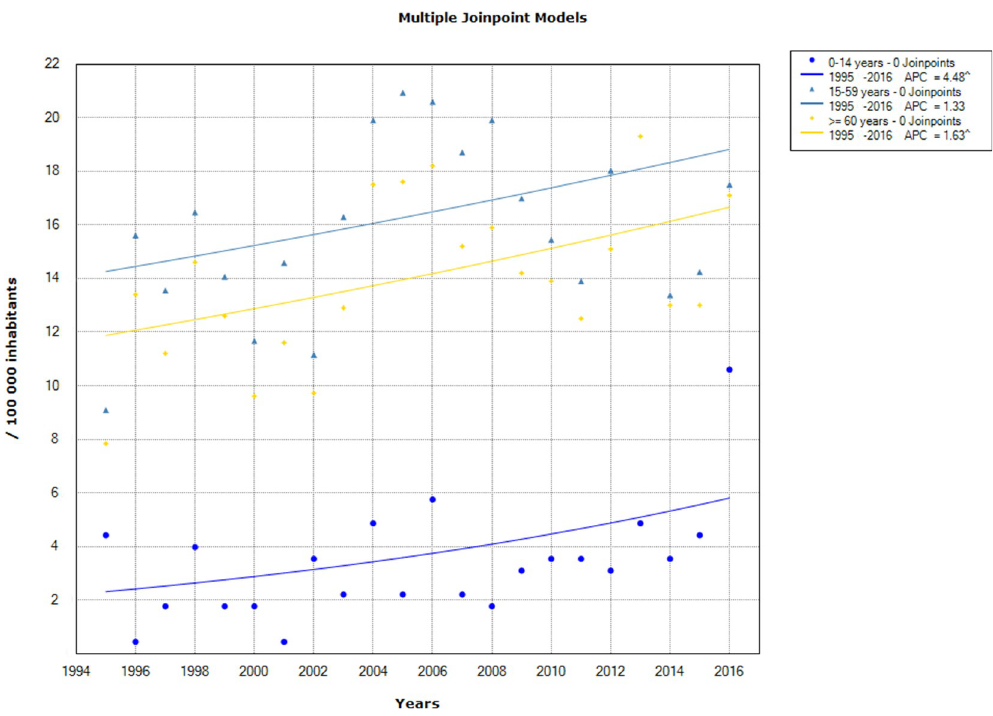
Fig 3. Chronological trends analysis of tuberculosis incidence rates by age groups between 1995 and 2016.